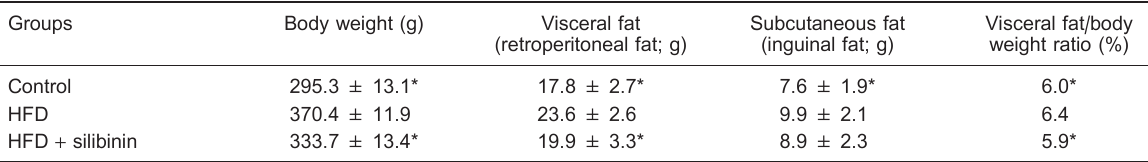
Table 2. Weight of fat at different sites, body weight and visceral fat/body weight ratio of rats.